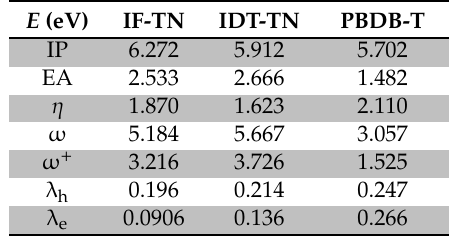
Table 2. Ionization potentials, electron a ffi nities, hardness, electrophilicity indexes, electro-accepting powers, and reorganization energies of the NFAs IF-TN and IDT-TN, and donor PBDB-T.